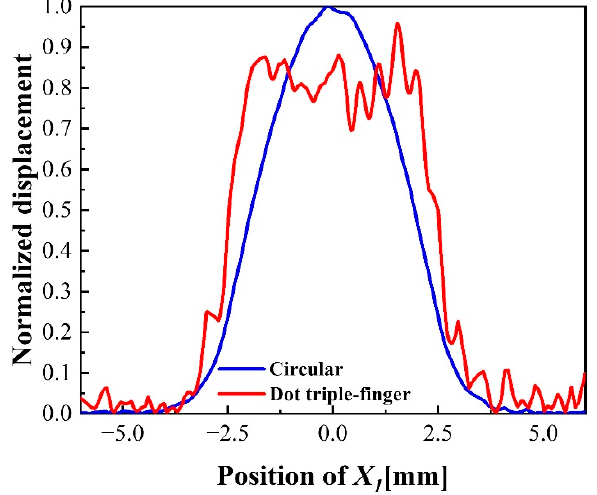
Figure 8. Vibration displacement distribution of dot triple-finger and circular electrode.